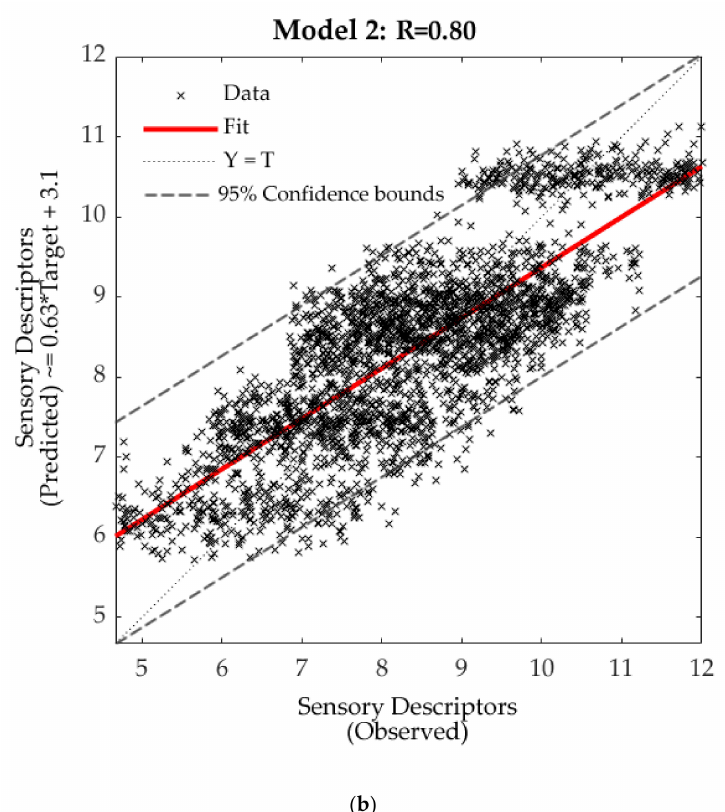
Figure 6. Overall regression of ( a ) Model 1 to predict living and dead tissue (%), throughout four measurement dates within the 2014-15 season for Pinot Noir berries and ( b ) Model 2 for 19 sensory descriptors (Table 1) for wines (scale 1–15) from blocks 92 and 96. R = correlation coe ffi